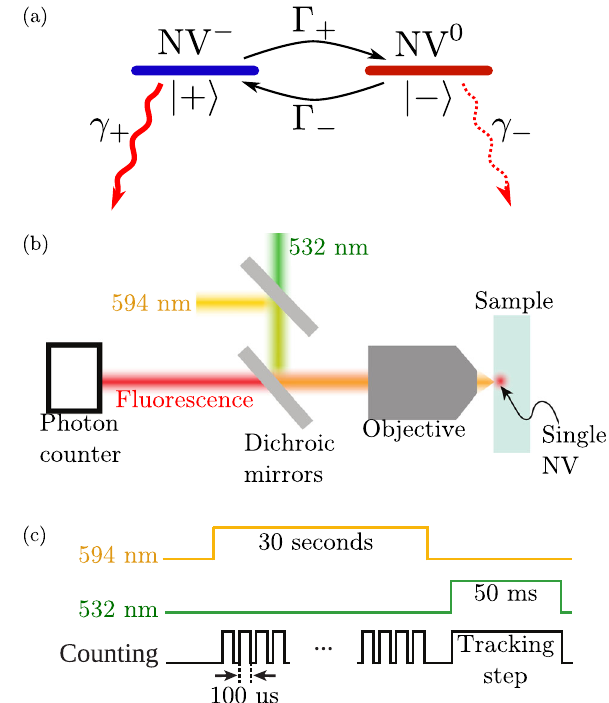
FIG. 3. Schematic representation of (a) the NV-center charge dynamics described in Sec. IVA, (b) the experimental apparatus, and (c) the